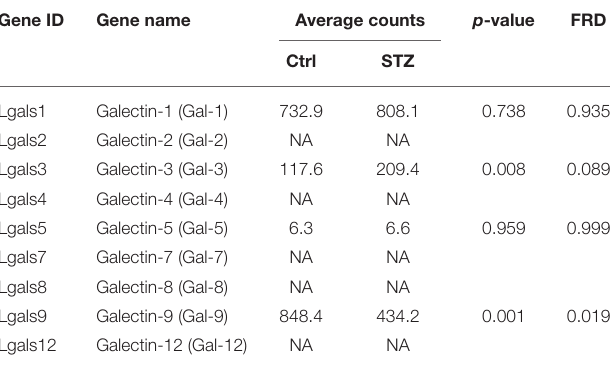
TABLE 5 | Summary of galectin genes from kidney IM by RNA-seq